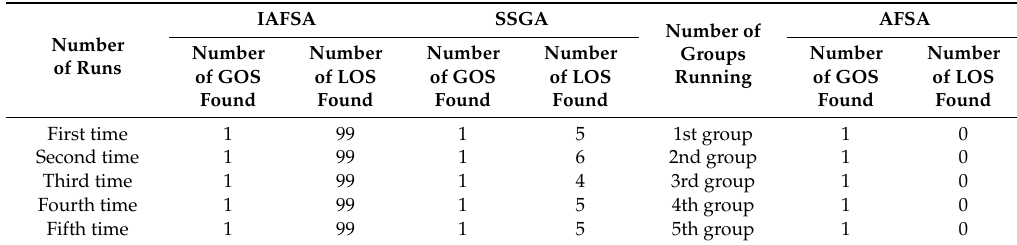
GOS: global optimal solutions, LOS: local optimal